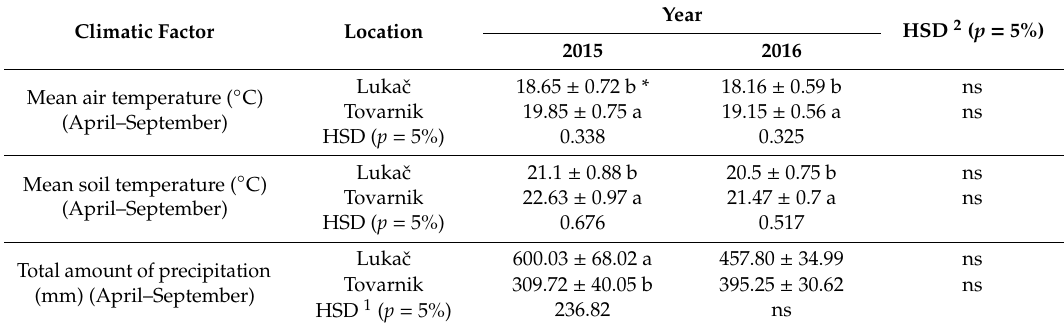
Table 1. Characteristics of the weather conditions prevailing at the two locations where the field investigations were carried out and the corresponding ANOVA results.